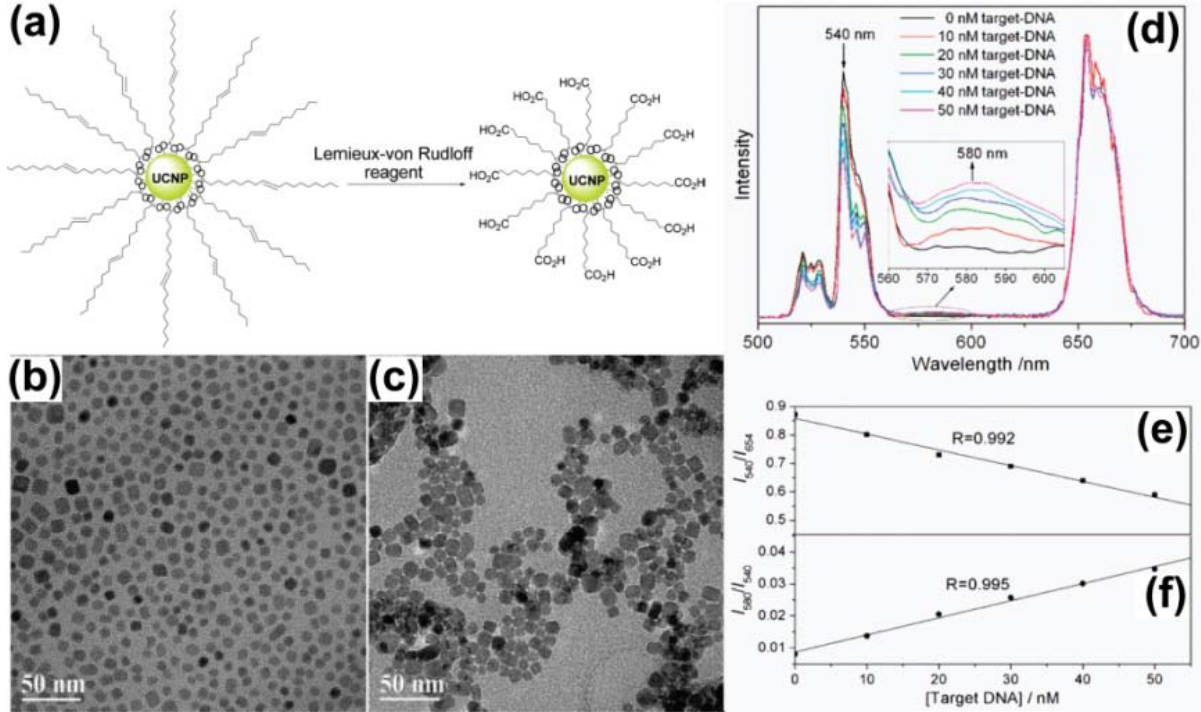
Figure 10. ( a ) Schematic illustration of the ligand oxidization process; ( b , c ) TEM images of the NaYF 4 :Yb/Er nanoparticles before and after ligand oxidization, respectively; ( d ) Luminescence spectra of a mixture of streptavidin-functionalized NaYF 4 :Yb/Er nanoparticles, capture-DNA, and reporter-DNA in the presence of different concentrations of target-DNA under continuous-wave excitation at 980 nm. The linear relationships between target-DNA concentration and the intensity ratios of ( e ) I540/I654 and ( f ) I580/I540. Reproduced from [112]. Copyright 2008, American Chemical